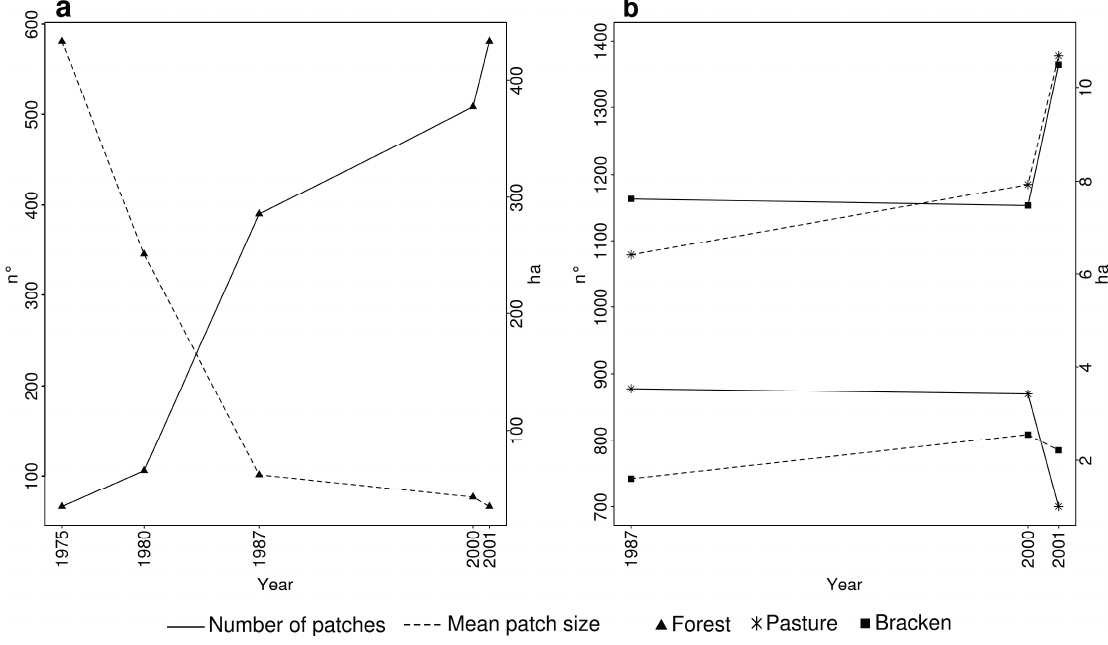
Figure 8. Number of patches and mean patch size of ( a ) forest and ( b ) pasture and